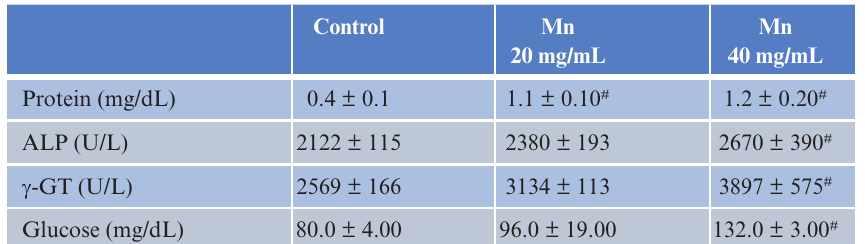
Table 2. Urinalysis of manganese (Mn)-treated animals.